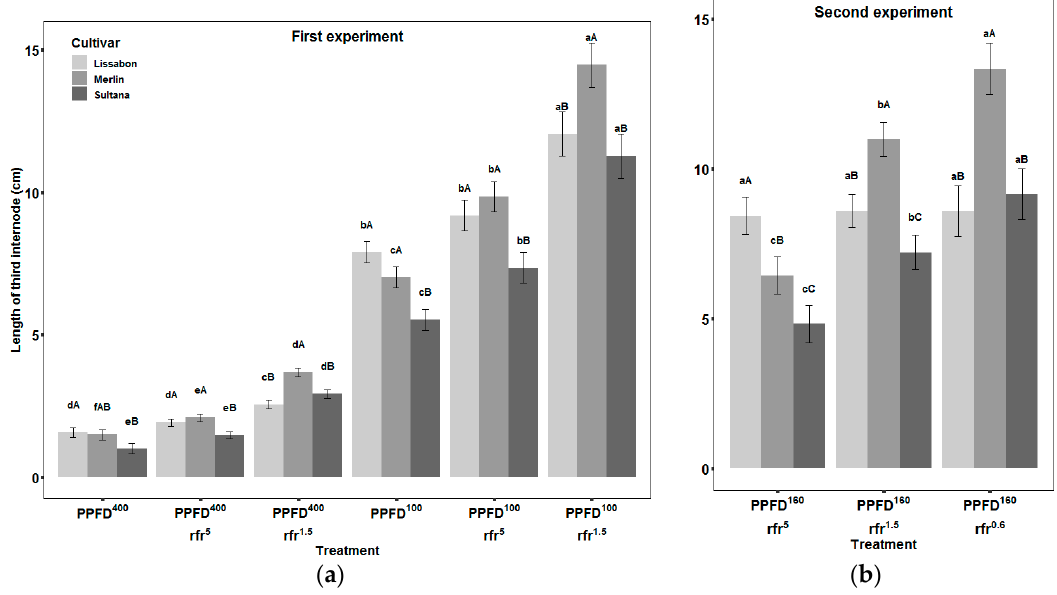
Figure 3. The least square means of third internode length for the three cultivars in first ( a ) and second ( b ) experiment. Error bars indicate standard error of the LS-mean. For each experiment, lower case letters indicate significant differences between treatments for each cultivar, and upper case letters indicate significant differences between cultivars for each treatment ( p < 0.05).